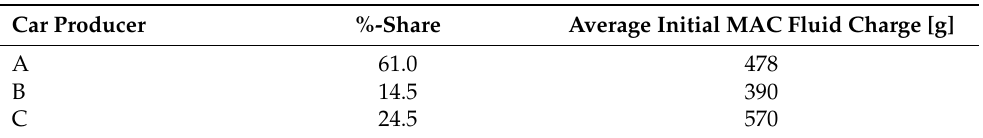
Table 4. Annual percentage of the total production and average initial charge of Czech passenger car